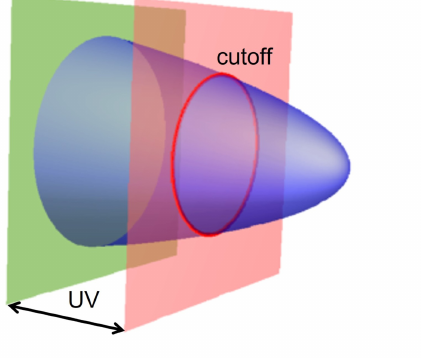
Figure 1 . The string dual to a Wilson loop is attached to a circle at the boundary (back green plane) and extends along the holographic radial direction. Introducing a radial cutoff (front red plane) separates the geometry in the UV region between the cutoff plane and the boundary, and the IR region at the other side of the cutoff. Removing the UV region leaves the IR section of the string plus a cutoff action defined at the boundary of the truncated string (red